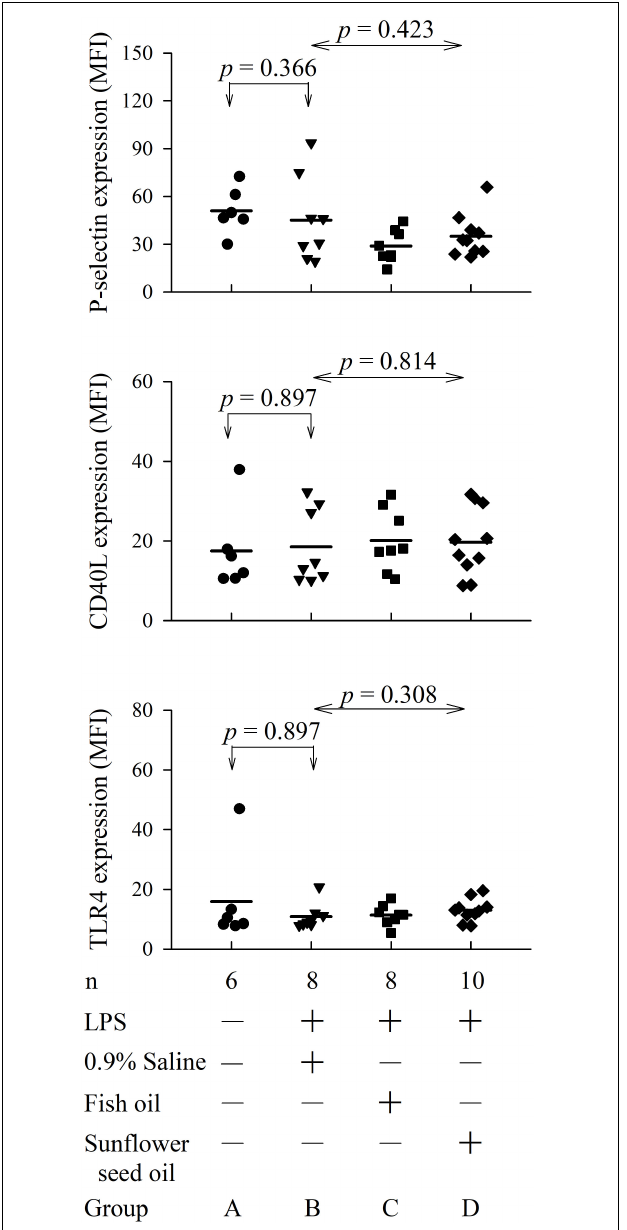
FIGURE 4 | Effects of dietary supplementation of fish oil and sunflower seed oil on platelet P-selectin, CD40L, and TLR4 expression in endotoxemic rats. Data are expressed as mean ± SD. MFI, mean fluorescence intensity; LPS, lipopolysaccharide; n, number of rats that